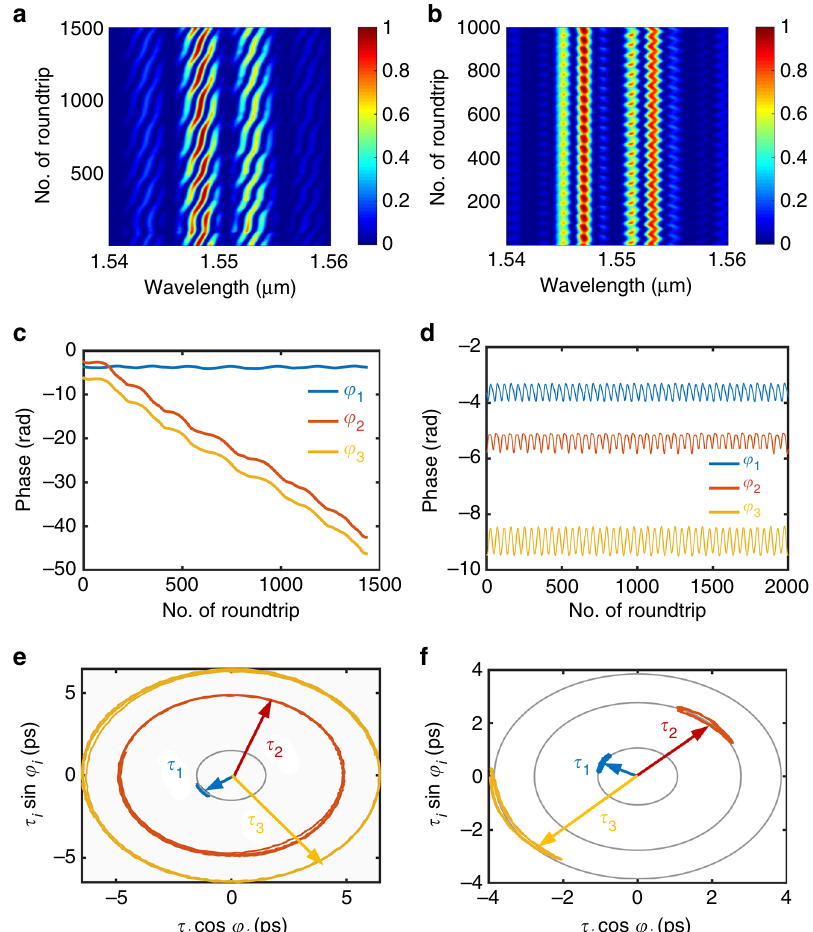
Fig. 5 Numerical simulations of the dynamics of soliton molecular complexes. a , c , and e correspond to a soliton molecular complex (SMC) with sliding- phase dynamics, obtained at pump power P = 86 mW and saturation power P sat = 6 W. b , d , and f feature an oscillating-phase SMC obtained at P = 104 mW and P sat = 7 W. a and b represent the spectral evolution of the sliding and oscillating SMCs, respectively, over successive cavity roundtrips (Spectral intensity in colour scale). c and d depict the evolution of the internal phases φ i = 1,2,3 within the SMC, in the sliding and oscillating SMC cases, respectively, as a function of the cavity roundtrip time. e and f display the trajectories of the relative temporal separations τ i = 1,2,3 and internal phases in the interaction plane representation, for the two different